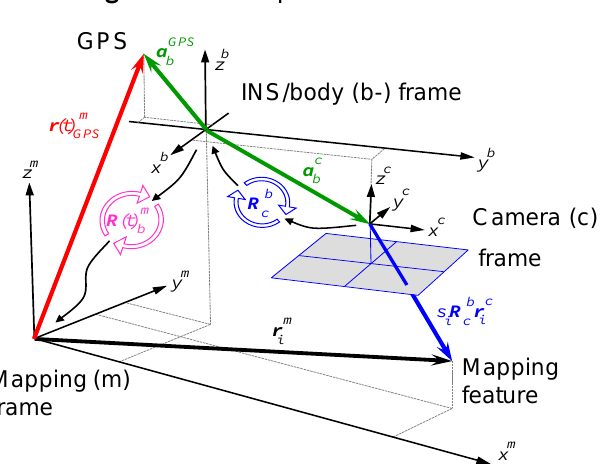
Figure 5. Concept of airborne DG.